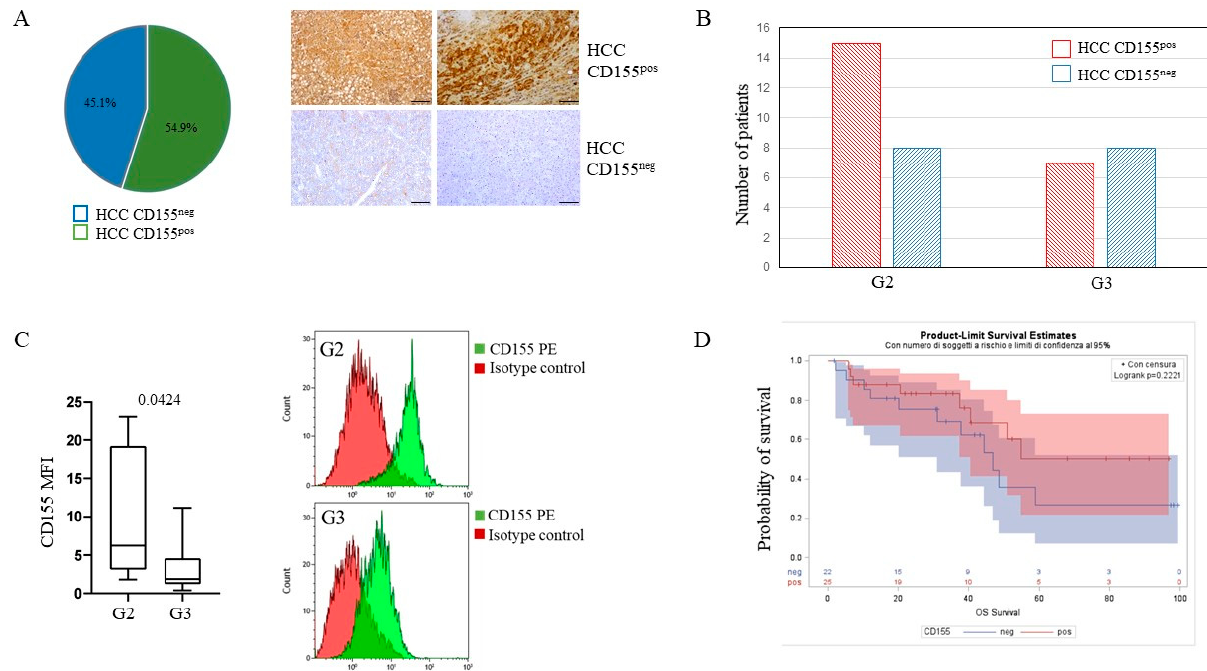
Figure 2. CD155 expression on tumor tissues. ( A ) Distribution of CD155 pos and CD155 neg HCC specimens and representative images of immunohistochemical analysis (n = 51). Representative images of CD155 positive (upper row) and negative (lower row) expressions in HCC tumor tissues at 10X magnification, bars: 100 µ m. ( B ) Distribution of the same CD155 pos and CD155 neg HCC patients stratified according to tumor grading (moderate and poorly differentiated, G2 and G3 respectively). ( C ) Expression of CD155 in HCC primary cells from G2 (n = 7) and G3 tumors (n = 10) evaluated by flow cytometry (MFI, calculated as CD155 MFI-isotype control MFI). Representative histograms of CD155 expression in HCC primary cells derived from a G2 and a G3 tissue. ( D ) Overall survival of HCC patients according to CD155 expression.